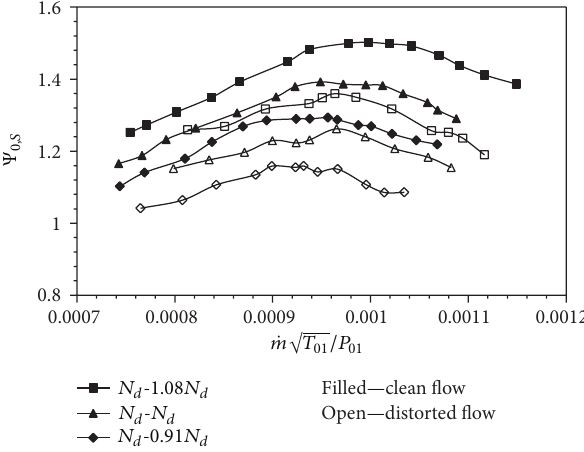
Figure 3: Performance characteristics under clean and hub-strong radial inflow